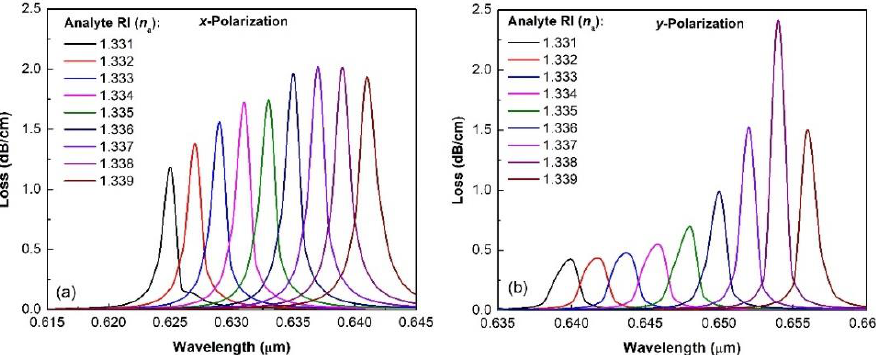
Figure 6. The wavelength dependent loss spectra for different analyte RI: ( a ) x and ( b ) y polarized modes for the graphene layer thickness of 40.12 nm.